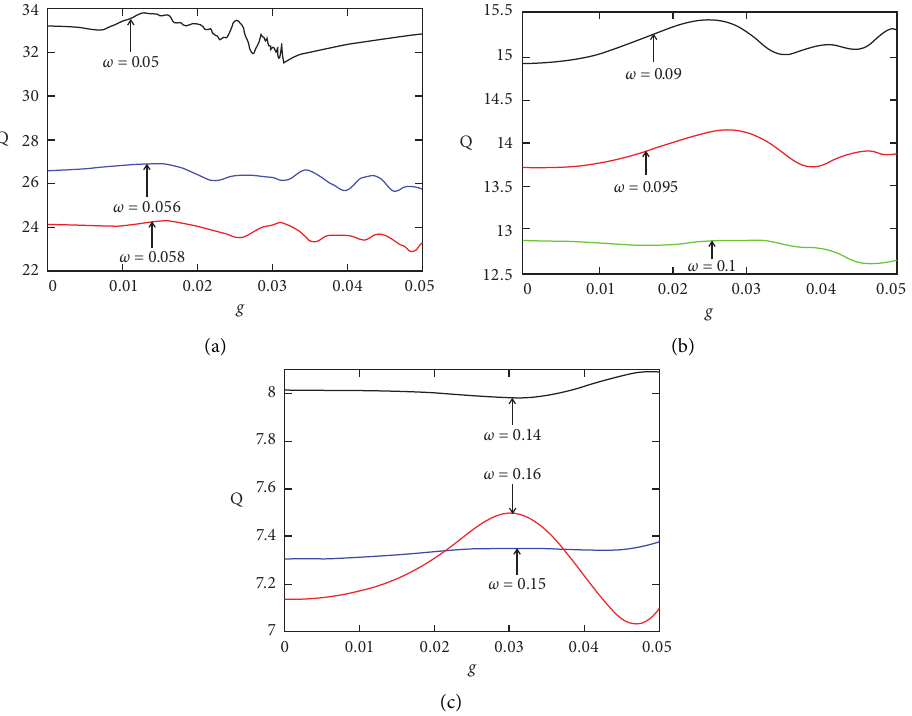
Figure 8: Effect of frequency ω on response amplitude Q versus g with ω � 0.0481, Ω � 80 ω , α � 0.0413, β � 0.0667, and f �